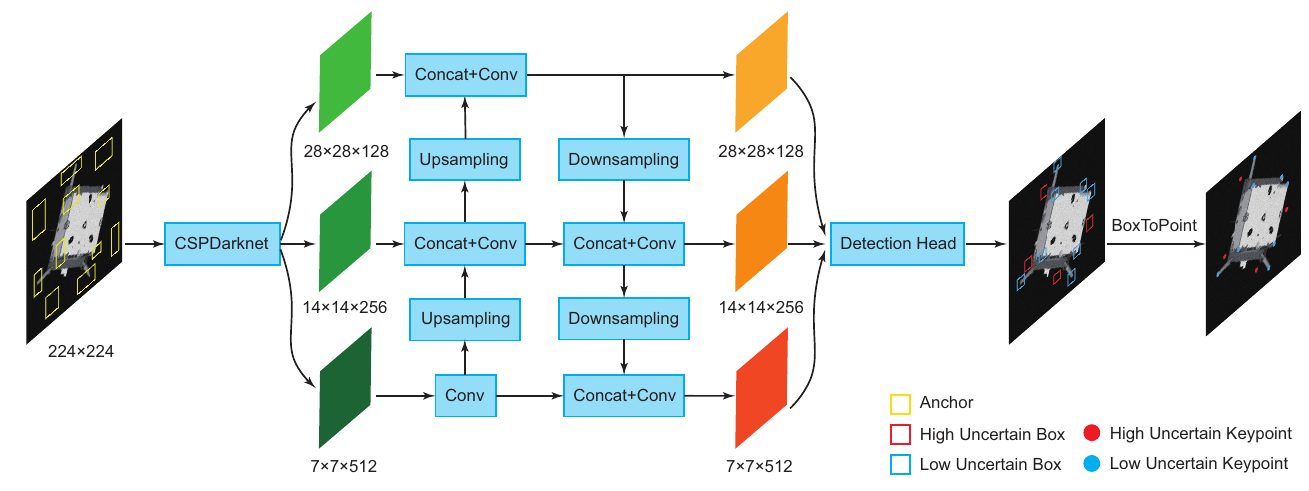
Figure 3. The framework of our